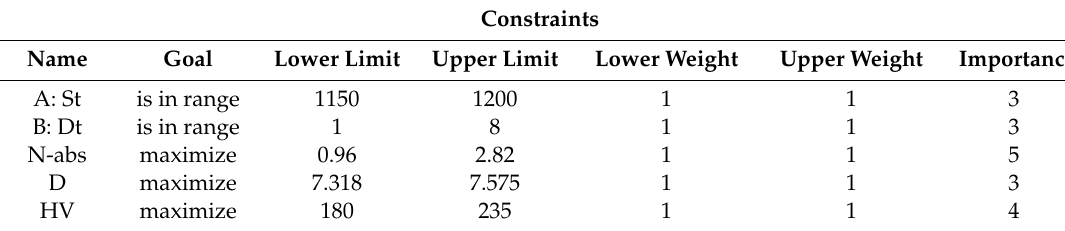
Table 13. Constraints of the